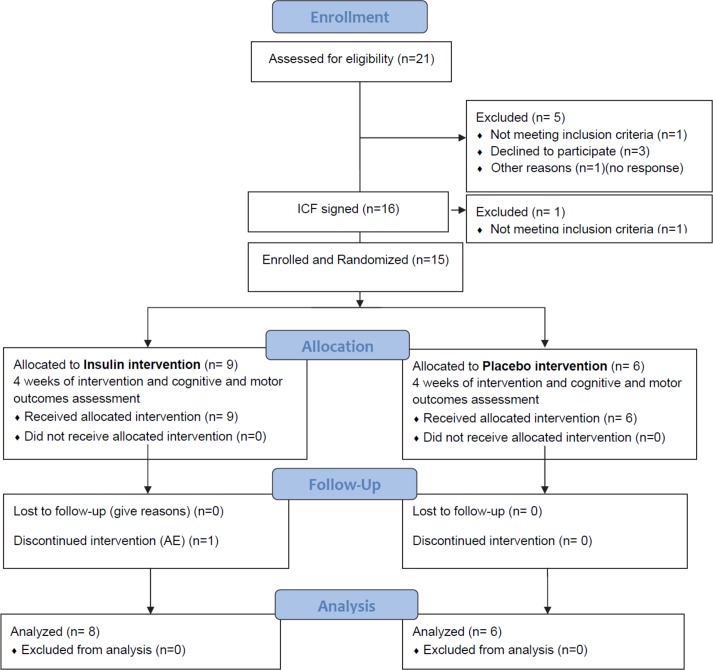
Study flow diagram.